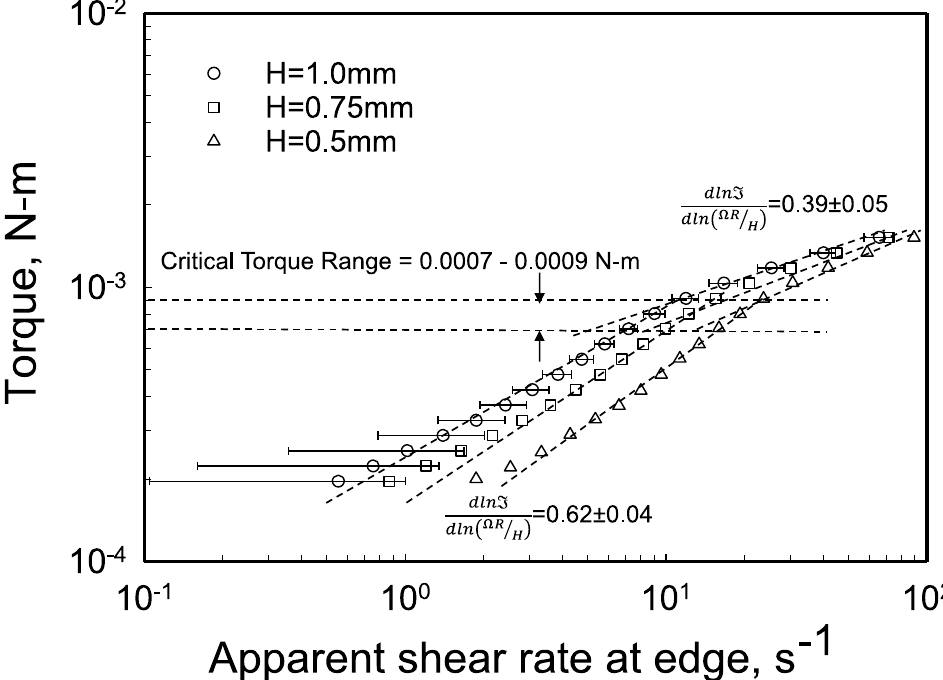
ℑ Figure 5. Steady torque, (cid:61) , versus the apparent shear rate at the edge for three gaps. The critical Figure 5. Steady torque, , versus the apparent shear rate at the edge for three gaps. The critical torque corresponds to the yield condition from which the yield stress can be determined. torque corresponds to the yield condition from which the yield stress can be determined. The torque, (cid:61) , that is necessary to rotate the upper disk at a given apparent shear rate . = Ω R / H , is given γ at the edge, aR